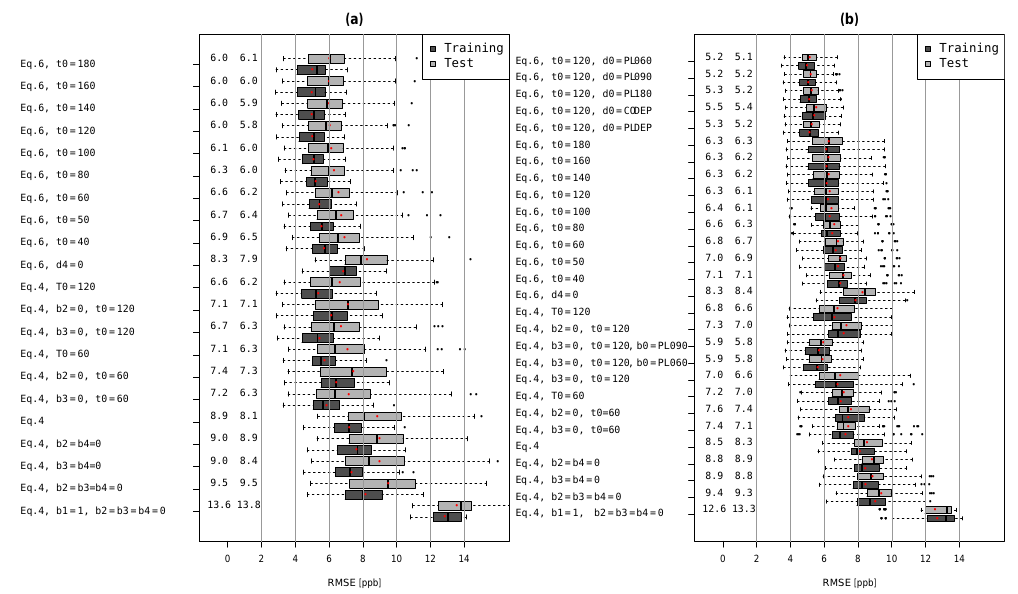
Figure 3. Performance of NO 2 sensor models based on Eqs. (4) and (6). (a) Model parameters estimated based on data when the SUs ran in parallel with instruments of AQM sites (PAR). The threefold cross-validation utilises the first, second and third parts of the data as test data while the remaining data are part of the training data set (threefold cross-validation, three permutations). (b) Model parameters estimated based on data from when the SUs ran in parallel with instruments of AQM sites and remote (PAR/REM). Data from every third day are part of the training data set, data from the remaining days are part of the test data set (threefold cross-validation, three permutations). Only NO 2 B42F sensors were included in (a, b) . The terms PLX, PLDEP and CODEP refer to the parameters b 0 and d 0 in Eqs. (4) and (6). b 0 and d 0 are constants if not specified. PLX denotes a piecewise linear function with an interval length of about X days, PLDEP denotes a piecewise linear function with the intervals being equal to the deployment periods and CODEP denotes a stepwise function with the intervals being equal to the deployment periods. T0 refers to the parameter (cid:49)t 0 in Eq. (2). The two numbers indicated for each model refer to the mean (red dot) and the median root mean square error